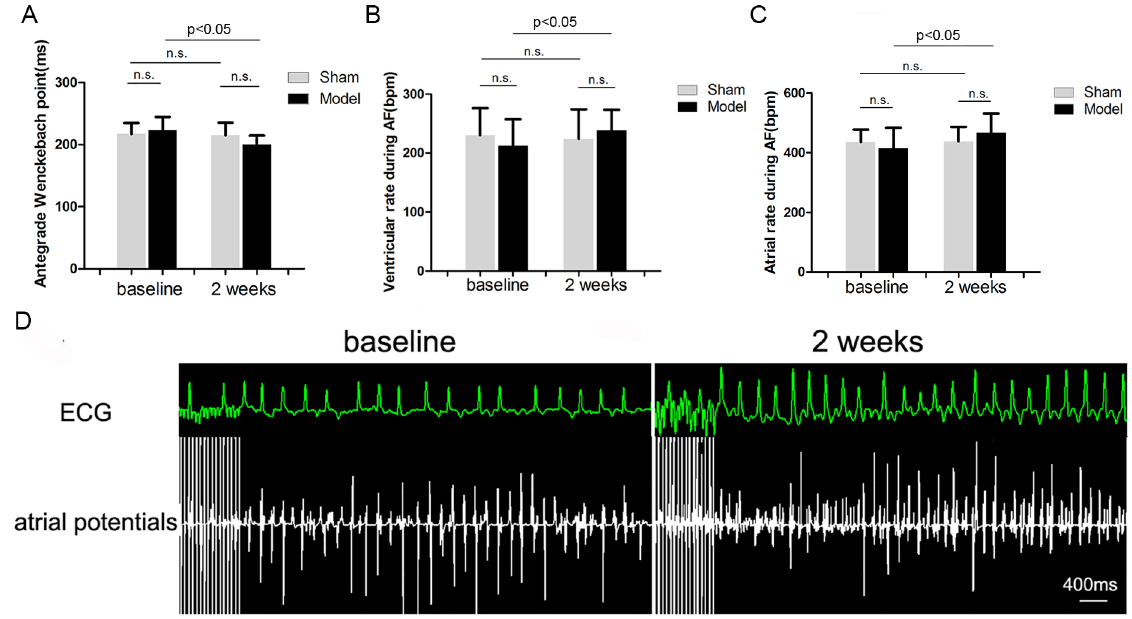
Figure 5. Electrophysiological effects of RI with mild renal insufficiency on AF and antegrade Wenckebach point (n=5). Effects of embolization versus sham operation on antegrade Wenckebach point (A), ventricular rate during AF (B) and atrial rate during AF (C). Representative right atrial potentials and ECG recordings after 10 seconds of rapid atrial pacing at baseline and with RI after 2 weeks of embolization in the model group